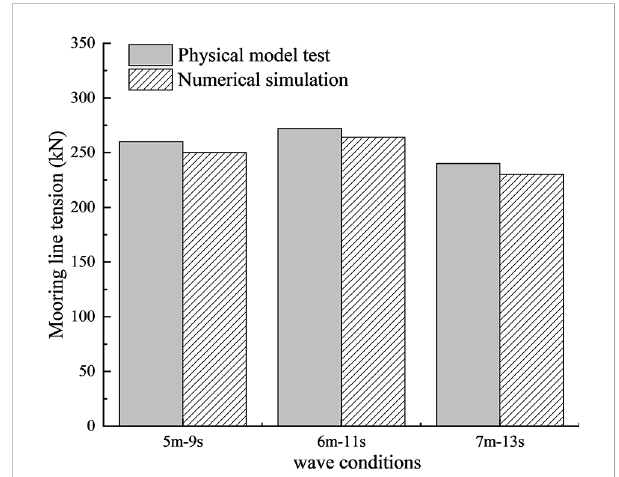
FIGURE 9 Comparison of mooring line tension peak between physical model test and numerical simulation.